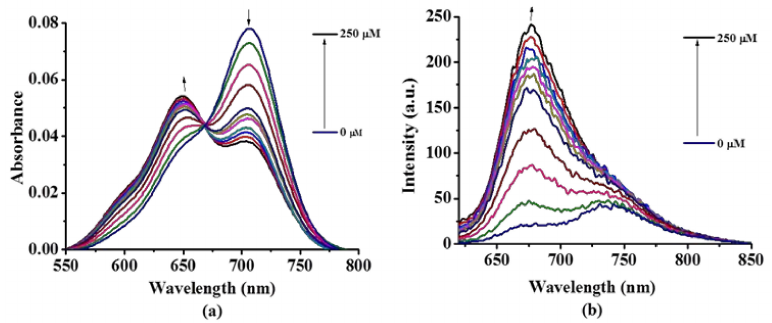
Figure 3. ( a ) Absorption and ( b ) fluorescence emission spectra of compound 7 (1 µ M) with different concentrations of H2O2 in phosphate buffer solution (10 mM, pH 7.4) with 0.05% Tween 80.